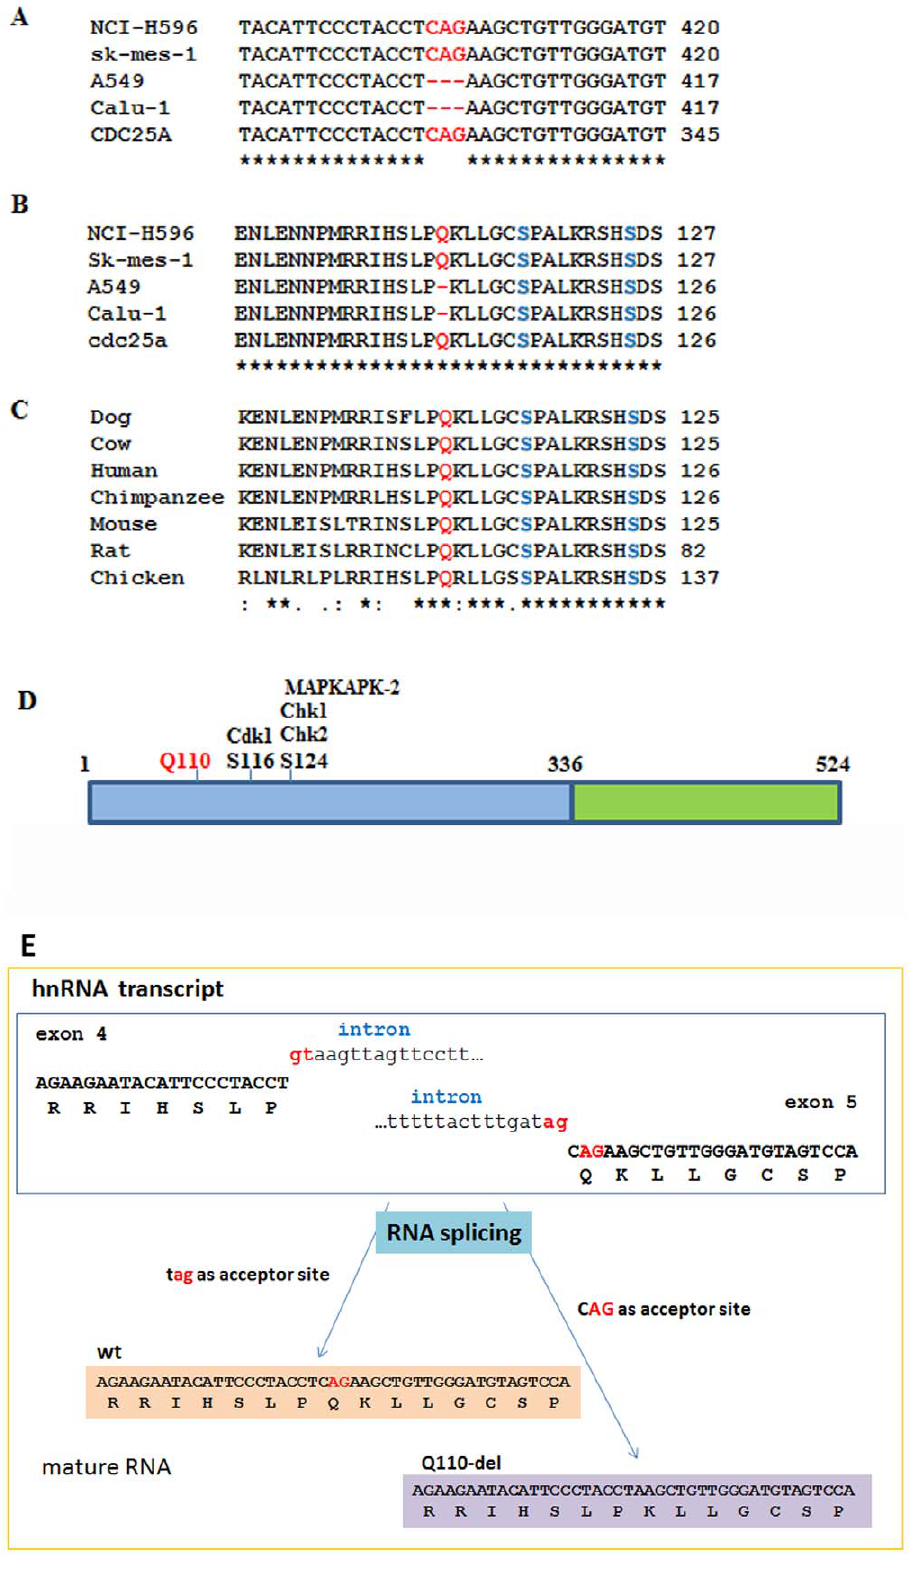
Figure 1. Identification of CDC25A Q110del isoform in NSCLC cell lines. A. Nucleic acid sequence of triplicate deletion CDC25A-CAG (328–30) in NSCLC cell lines. B. CDC25A-CAG (328–30) translates to Q110 deletion (CDC25A Q110del ). C. Amino acid Q110 of CDC25A is evolutionary conserved in other organisms. D. Q110 lies in the regulatory domain, closest to CDK1 mitotic stabilization phosphorylation site (S116) and Chk1 degredation phosphorylation site (S124). Red: CAG (328–30) nucleic acid deletion and corresponding amino acid Q110, shade: serine phosphorylation sites (S116